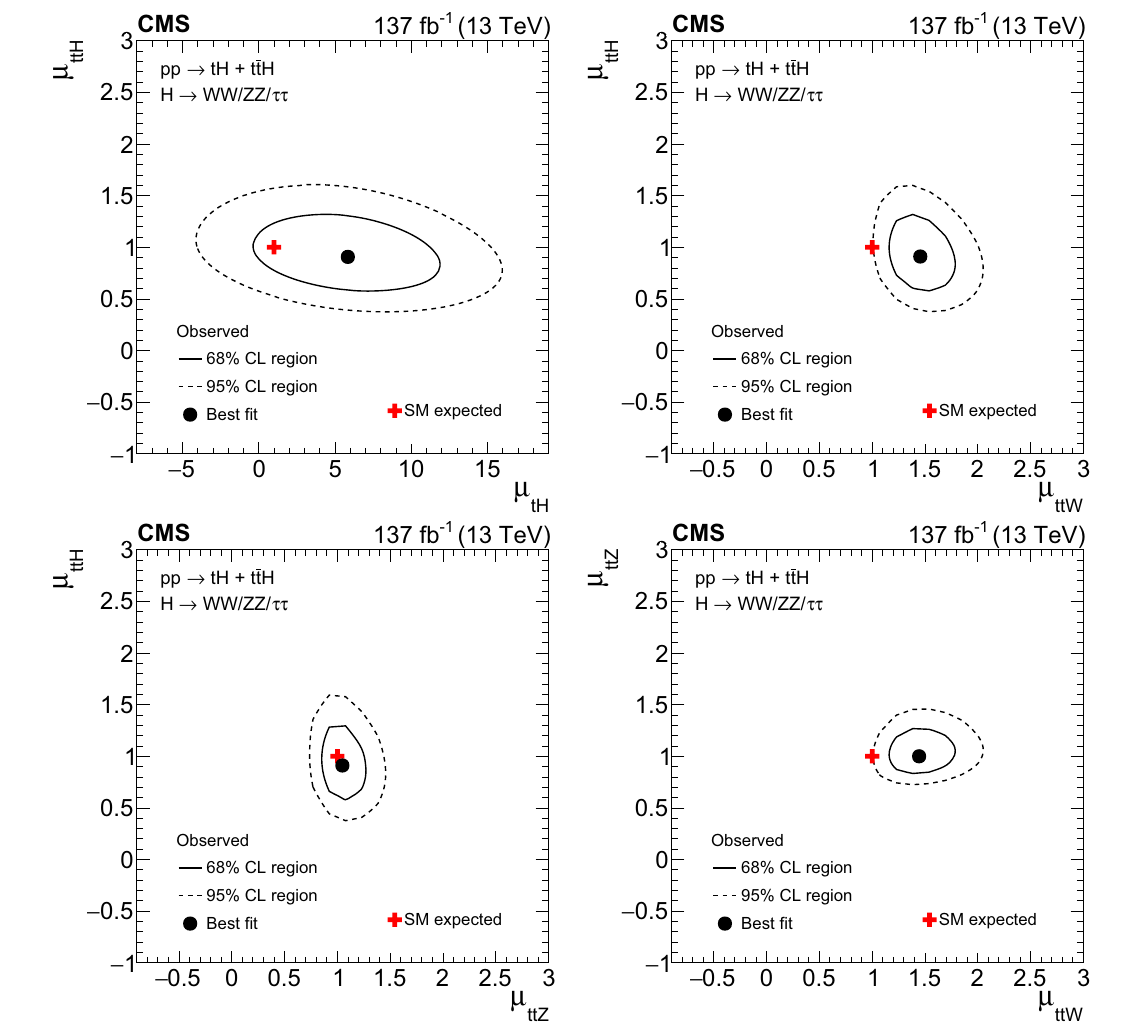
Fig. 15 Two-dimensional contours of the likelihood function L , given by Eq. (3), as a function of the production rates of the ttH and tH signals ( μ ttH and μ tH ) and of the ttZ and ttW backgrounds ( μ ttZ and μ ttW ).